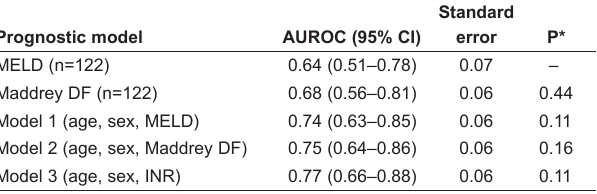
TABLE 3 discrimination of the prognostic models for